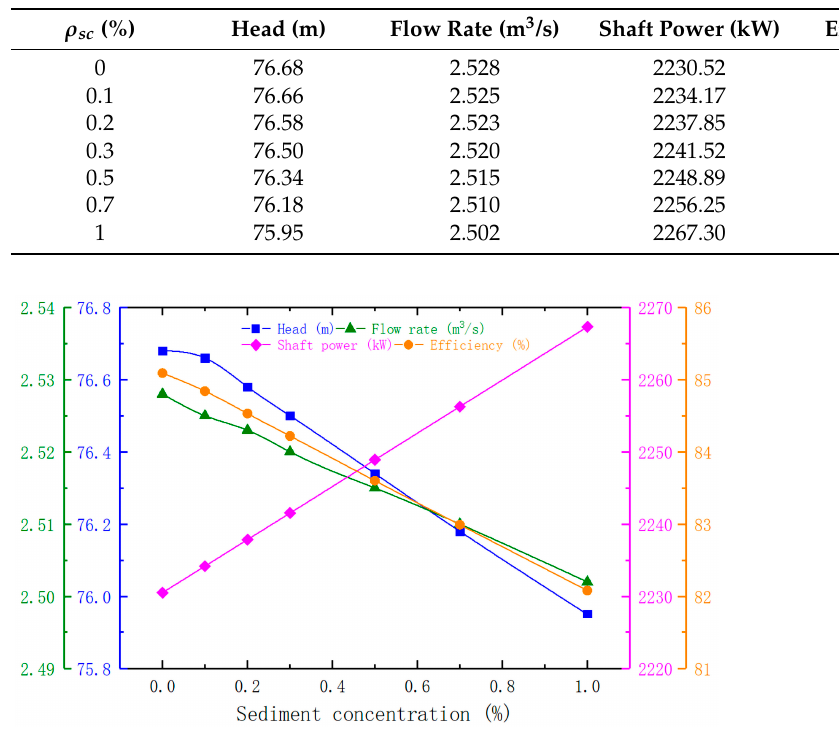
Figure 9. The variation trend diagram of performance parameters of centrifugal pump with different sediment concentrations at the design flow rate Q .